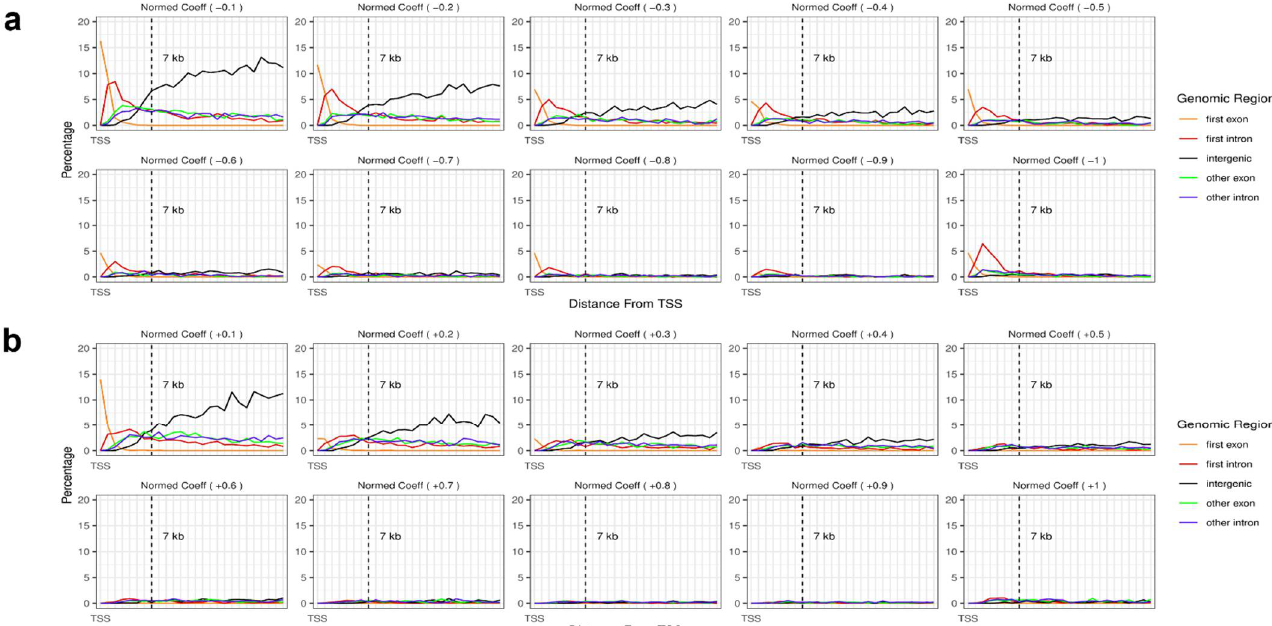
Figure 3. Regulatory effects represented by coefficients of CpG sites within genes. Effects of the probes within genes with ( a ) negative coefficients and ( b ) positive coefficients according to the distance from the TSS. The x -axis is the relative distance from TSS, and the leftmost point of the x -axis is TSS. The y -axis is the percentage of probes represented by dividing the number of probes with absolute normalized coefficients of 1 by the number of probes with absolute coefficients more than zero. The colors of the lines denote the genomic regions. Orange, first exon; red, first intron; black, intergenic; green, other exon; blue, other intron. Other exon/intron refers to all exons/introns in the transcript except the first exon/intron. Only downstream regions are plotted.